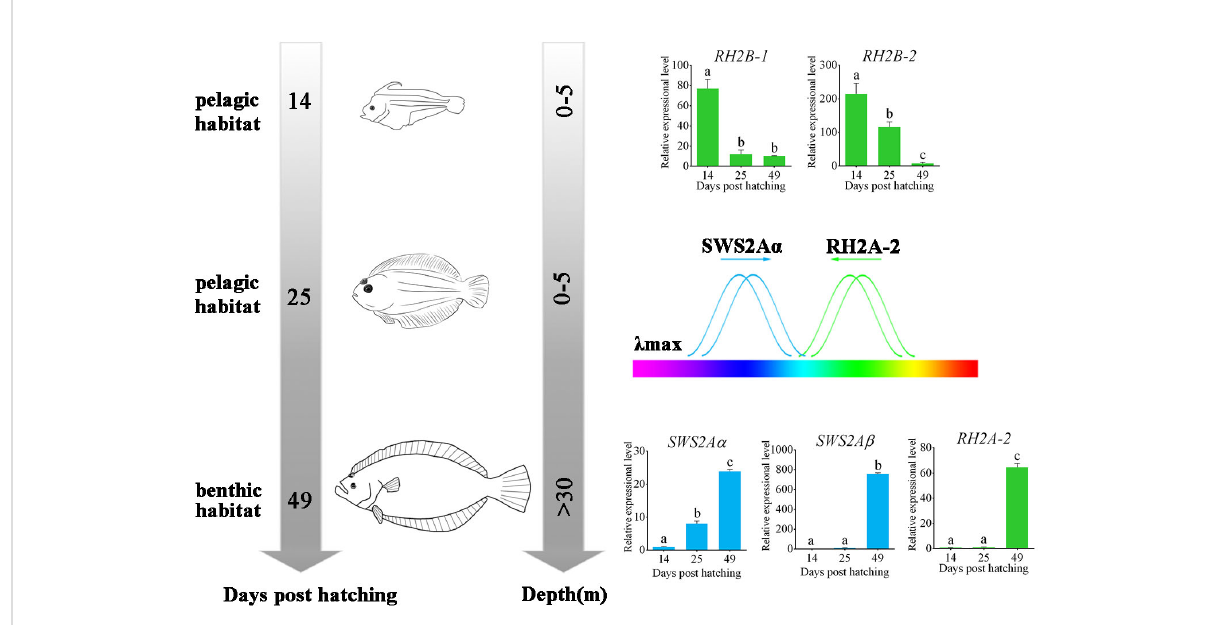
FIGURE 4 Schematic of metamorphosis and adapting benthic habitat of P. olivaceus . The wavelength shift by both RH2 and SWS2 opsins made P. olivaceus possess a broader wavelength adaptation from green to purple-blue lights. Different letters represent signi fi cant